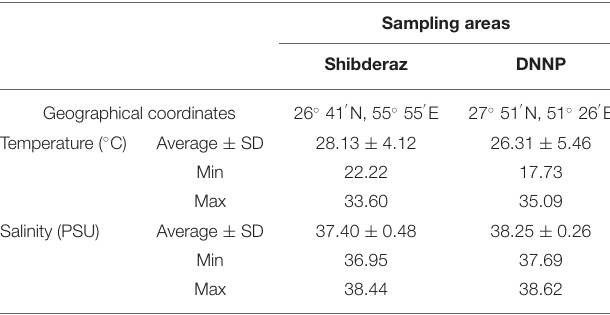
TABLE 1 | Sea surface temperature and salinity values at Shibderaz and Dayyer-Nakhiloo National Park (DNNP) during 2017 and 2018.